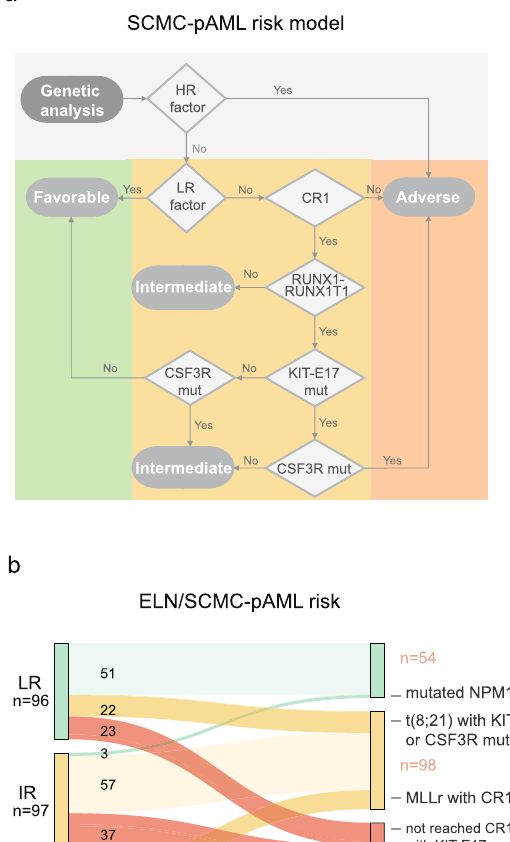
Fig. 5 Revised risk strati fi cation model for Chinese pediatric AML. a Flow chart of the revised risk strati fi cation model, SCMC-pAML, for Chinese pediatric AML. The model was constructed on top of the European LeukemiaNet (ELN) model, revised to include speci fi c clinically relevant driver alterations established in Chinese pediatric AML. b The revised SCMC-pAML model was used to re-stratify patients into risk groups. Risk groups from the SCMC-pAML model and ELN model are shown on the right and left, respectively. Colors indicate different risk factors, and line width is proportional to the number of cases. The genomic alterations leading to re-strati fi cation are labeled on the right. Numbers in the plot indicate the number of cases in each category. A total of 271 cases with suf fi cient follow-up information were re-strati fi ed using the SCMC-pAML model and included in survival analysis. c Event-free survival rate estimates for risk groups strati fi ed using the SCMC-pAML (dashed lines) and ELN model (solid lines). The SCMC-pAML model signi fi cantly increased the power of risk strati fi cation of Chinese pediatric AML patients, with low- and intermediate-risk patients showing more favorable outcome, and high-risk patients showing worse outcome (log-rank test, P = 2.859E